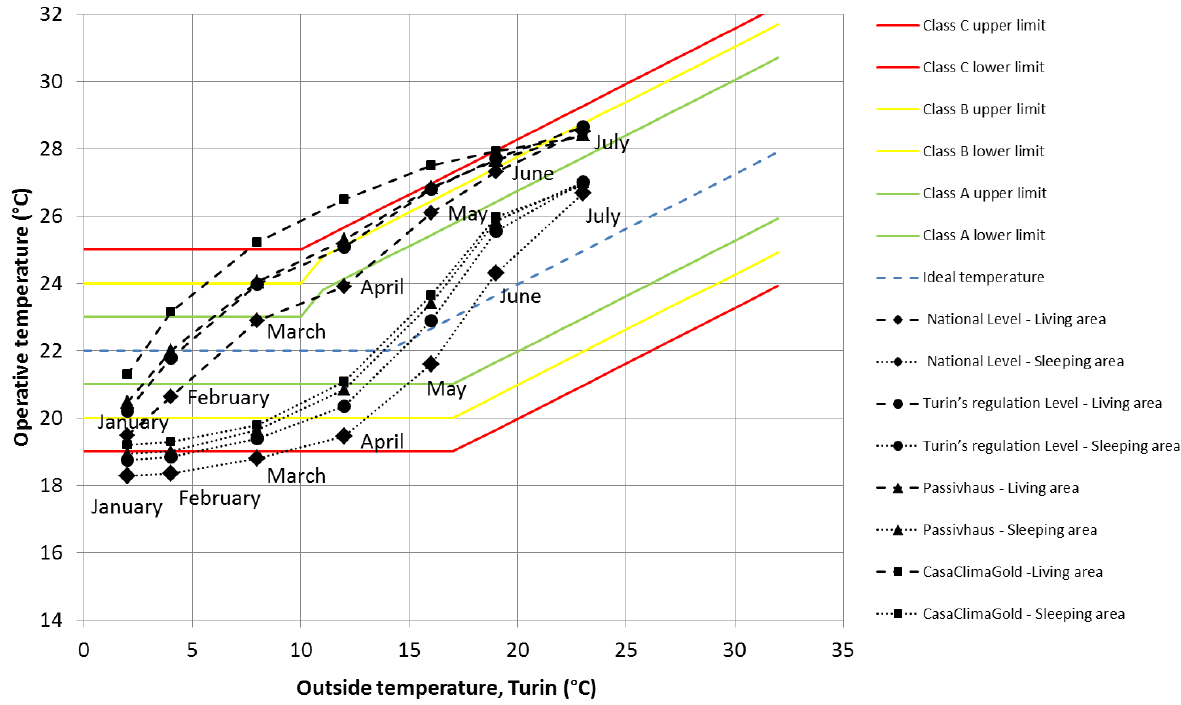
Figure 9. Comparison between different envelope levels of thermal insulation related to design scenarios in terms of monthly indoor operating temperature. Data from EN 15251:2008